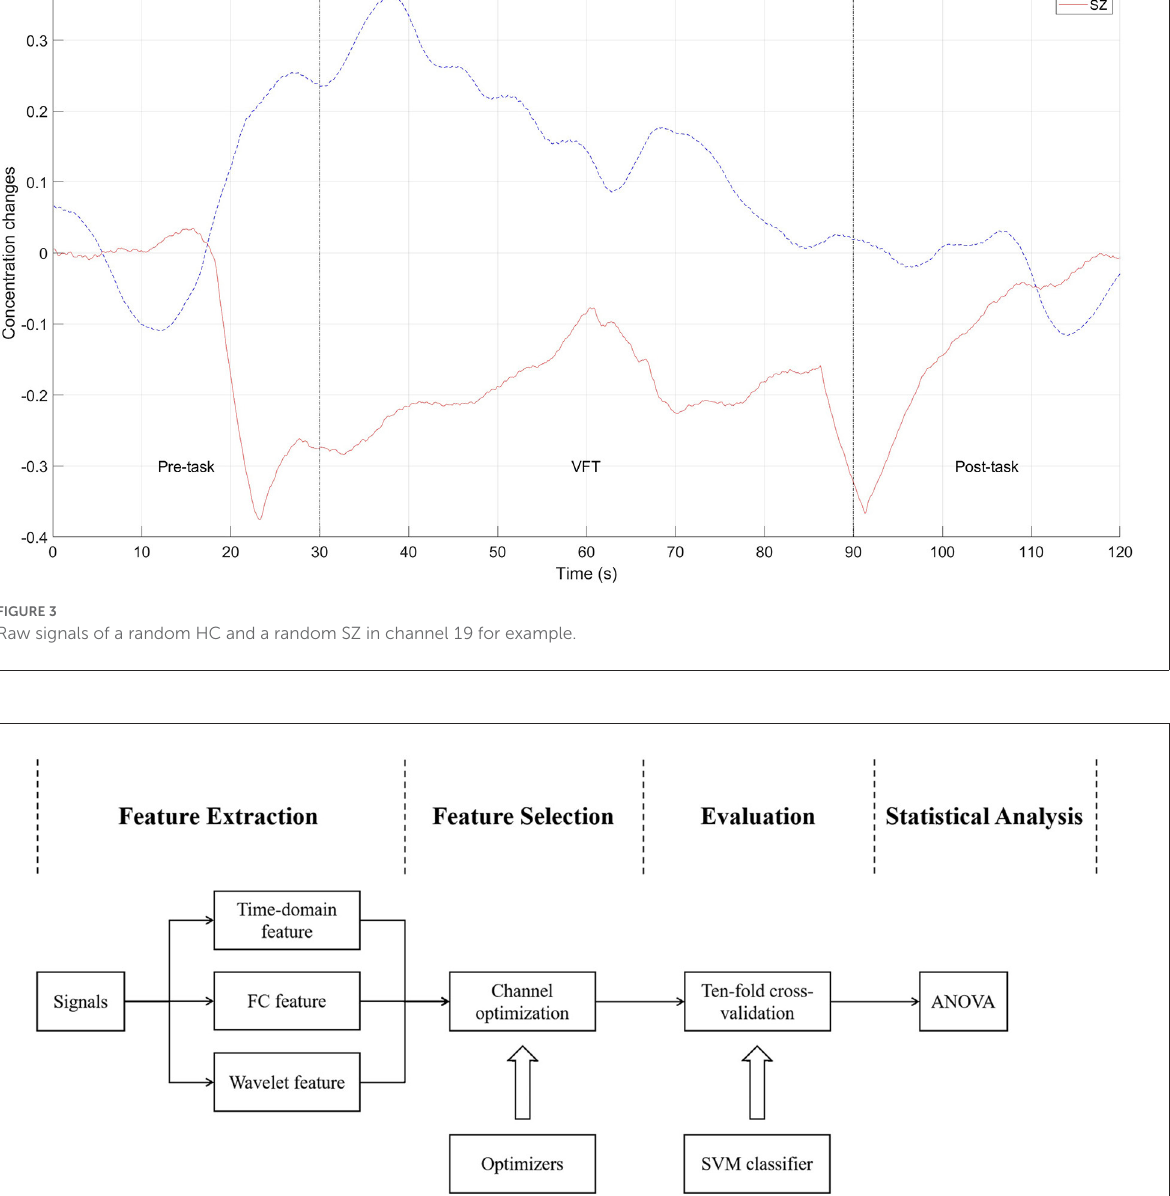
FIGURE4 Pipeline for signal processing. GA, PSO and their parallel and serial hybrid optimizers were used for channel optimization on three fNIRS features, respectively. SVM was chosen as the classifier. The classification performance of the selected features and classifiers was evaluated by ten-fold cross-validation. Statistical analysis was performed on the accuracy and the number of